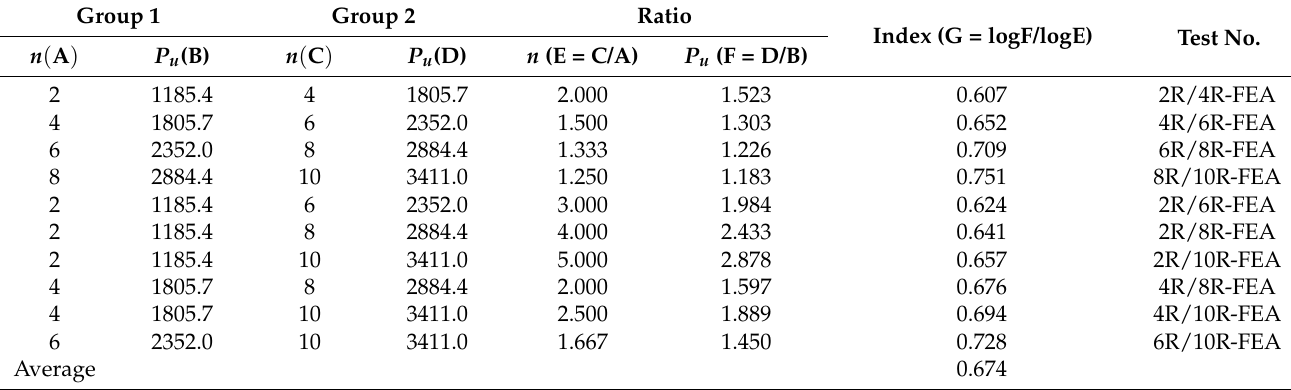
Table 15. Index value for the variable of n